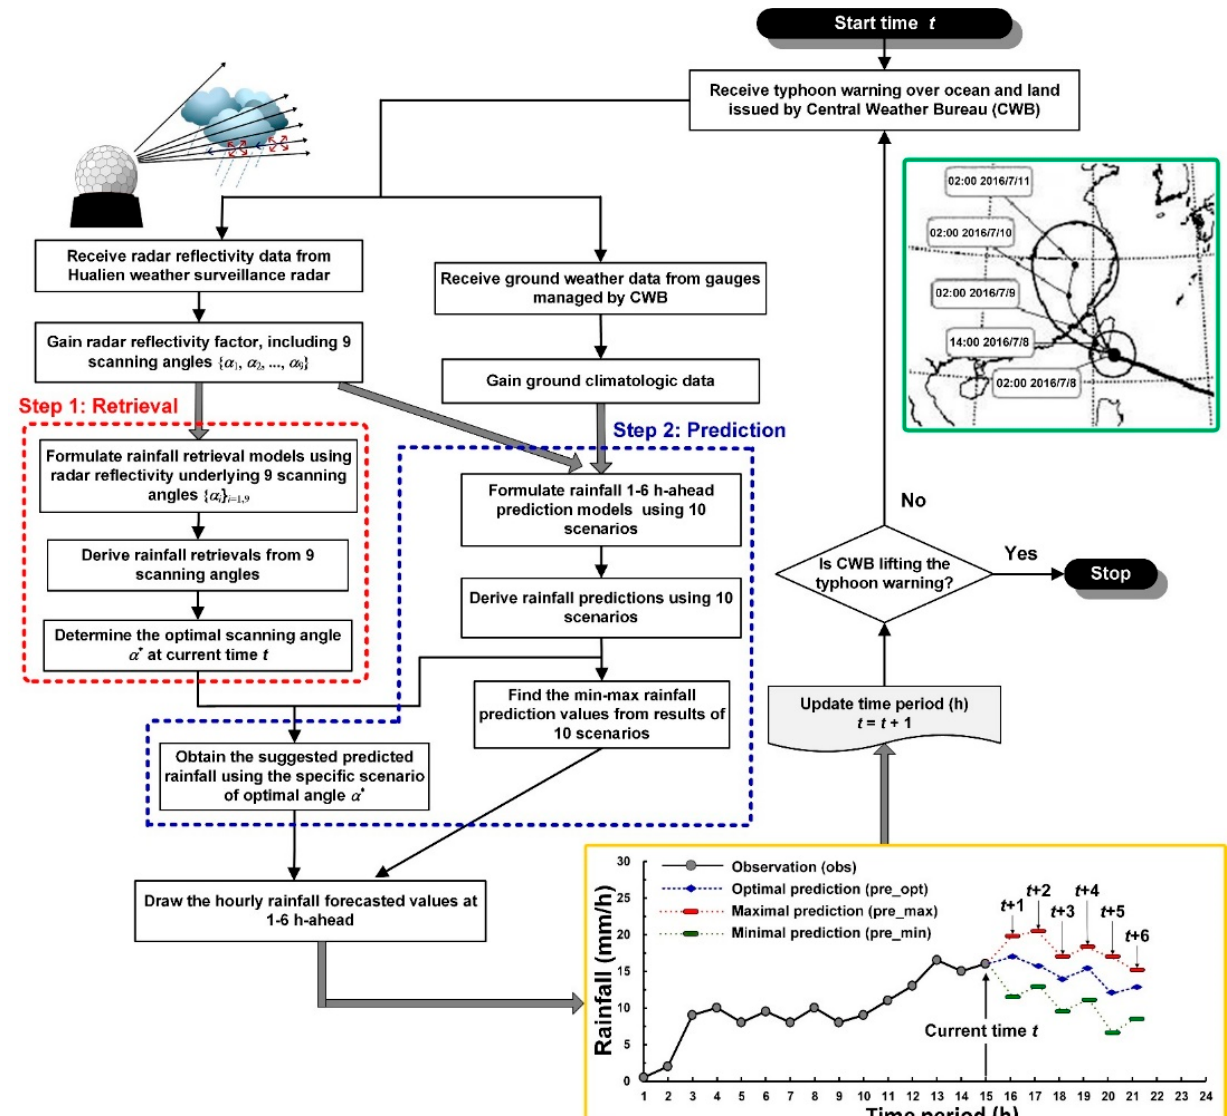
Figure 4. A real-time rainfall forecasting system during typhoons.